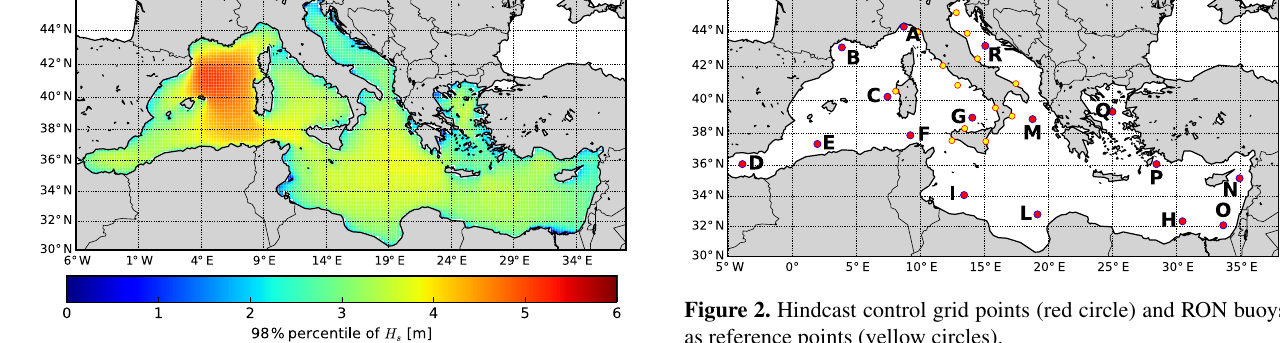
Figure 1. Value of significant wave height threshold in metres for the 98% percentile.